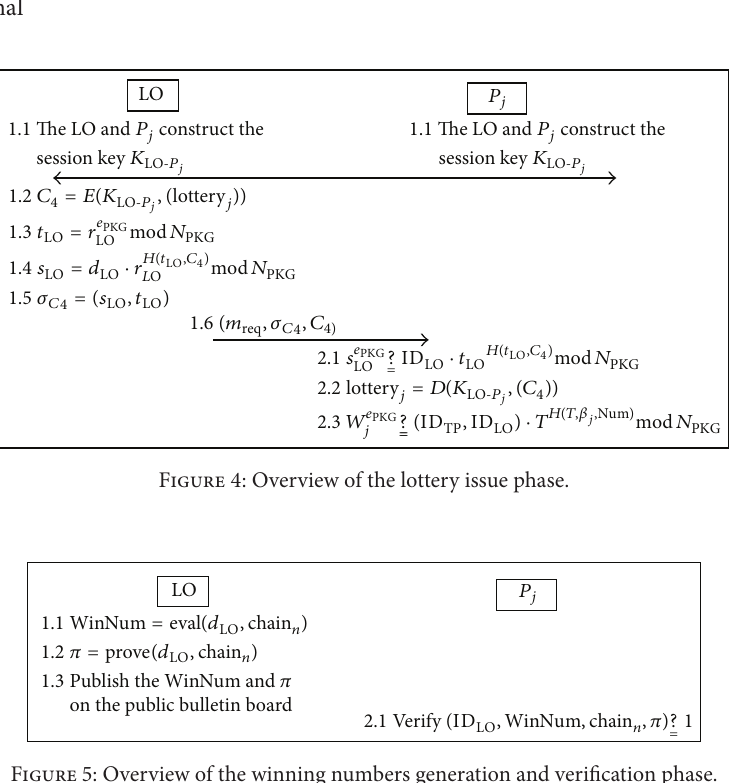
Figure 5: Overview of the winning numbers generation and verification